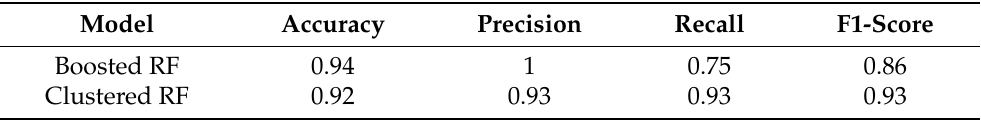
Table 2. Accuracy, Precision, Recall, and F1 Score for the prediction of patient mortality on the data used by Iwendi et al.